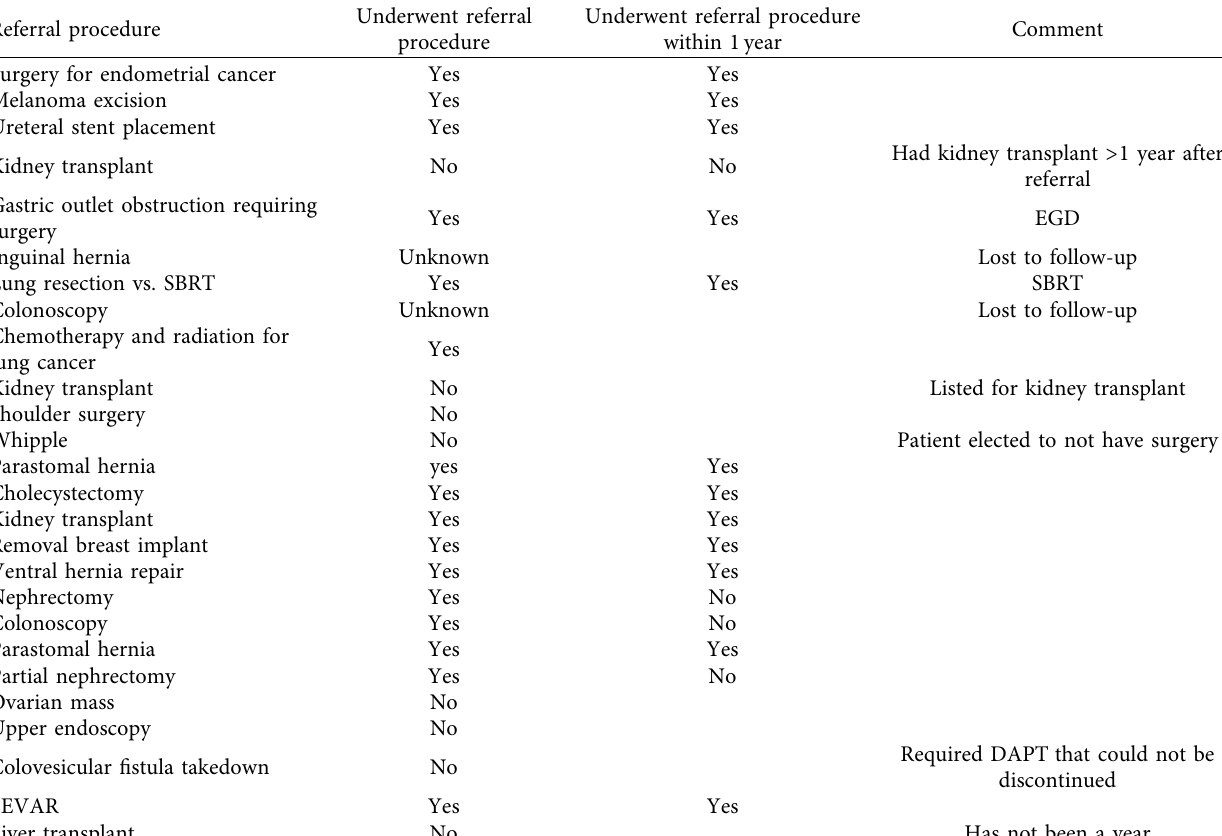
Table 4: Subset of patients referred by proceduralists and procedural